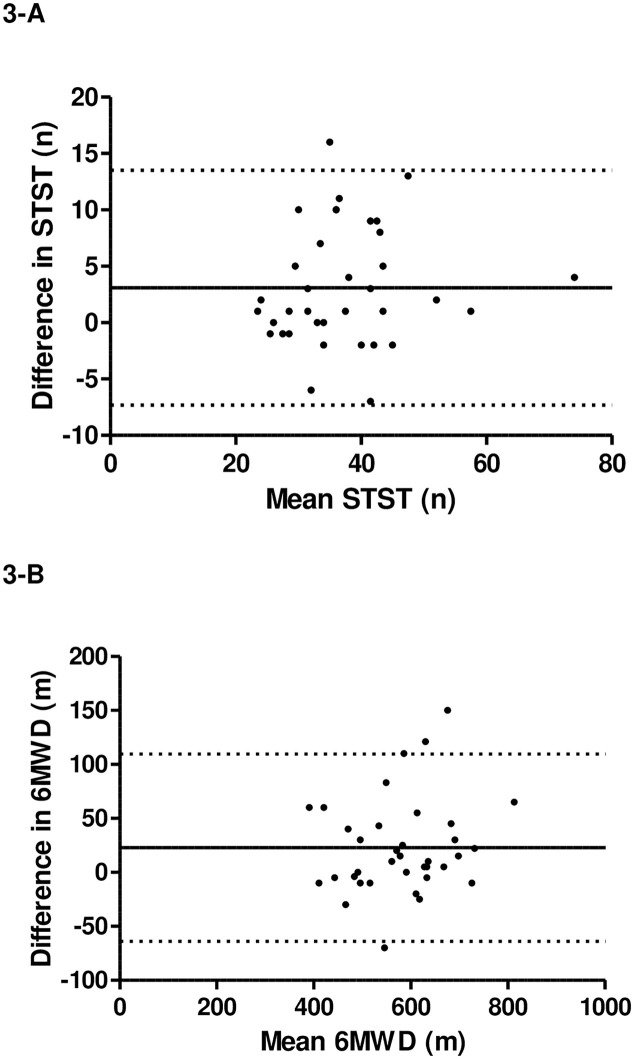
Two scatterplots showing: A: Repeatability of the delta and the average number (n) of movement repetitions performed during the STST and; B: Repeatability of the delta and the average distance walked (m) during the 6MWT by 36 children with CF aged 6–18 years (Bland-Altman method).